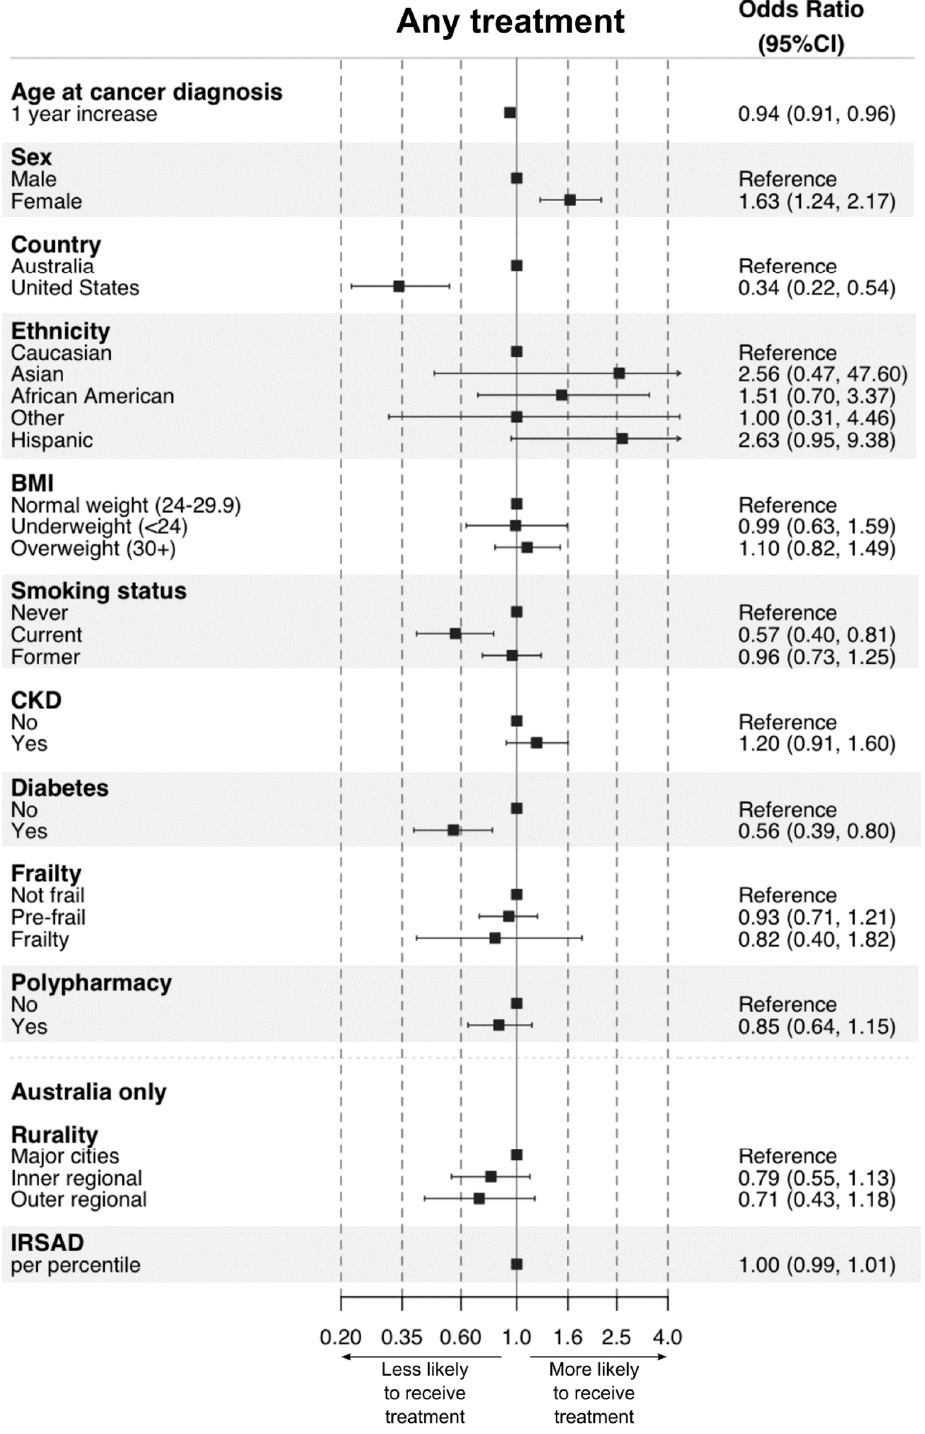
Figure 1. Associations between demographic factors, health behaviours, and chronic conditions and receipt of any cancer treatment for incident post-randomisation cancers during ASPREE.